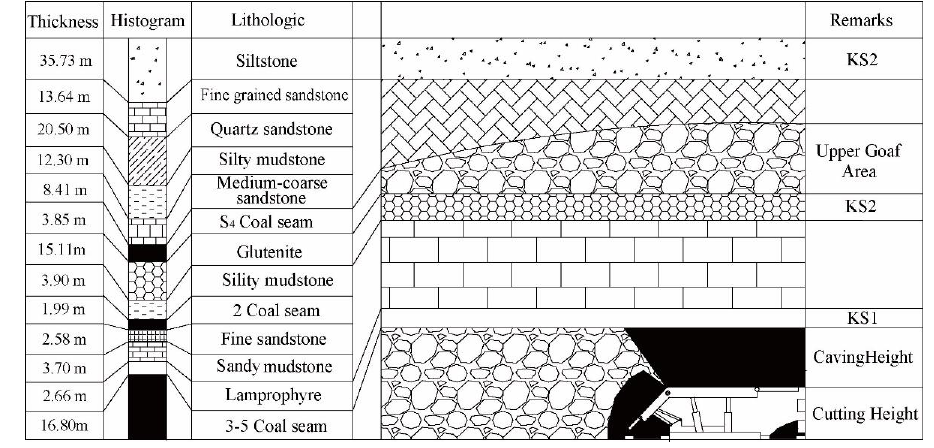
Figure 3. Stratigraphic column of the coal face.